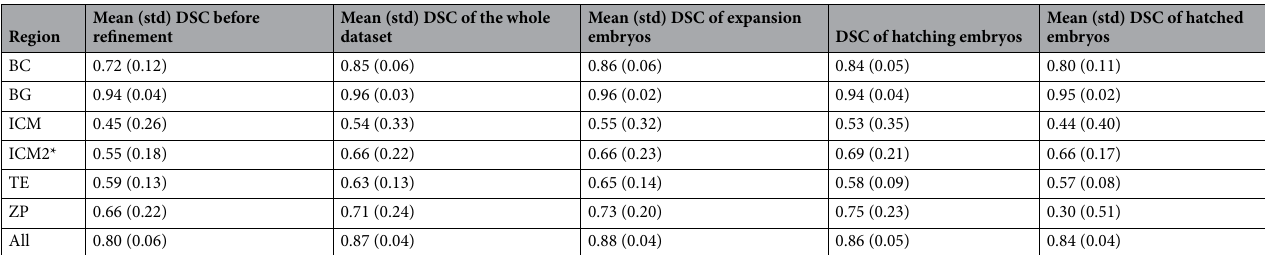
Table 1. Mean and standard deviation of Dice similarity coefficient for each region before and after the segmentation refinement step. ICM2* - Subset of the embryos filtering those where no ICM was identified by embryologists (20 expansion, and 15 hatching) The ‘All’ row includes the five regions and embryos where no ICM was found.